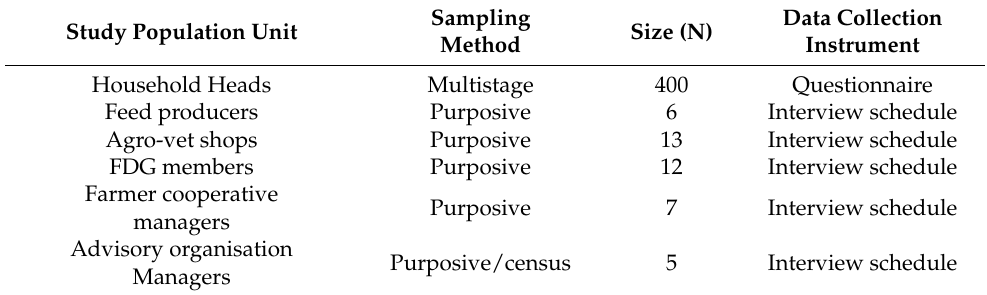
Table 2. Summary of Study Population Units, Sampling Method, and Data Collection